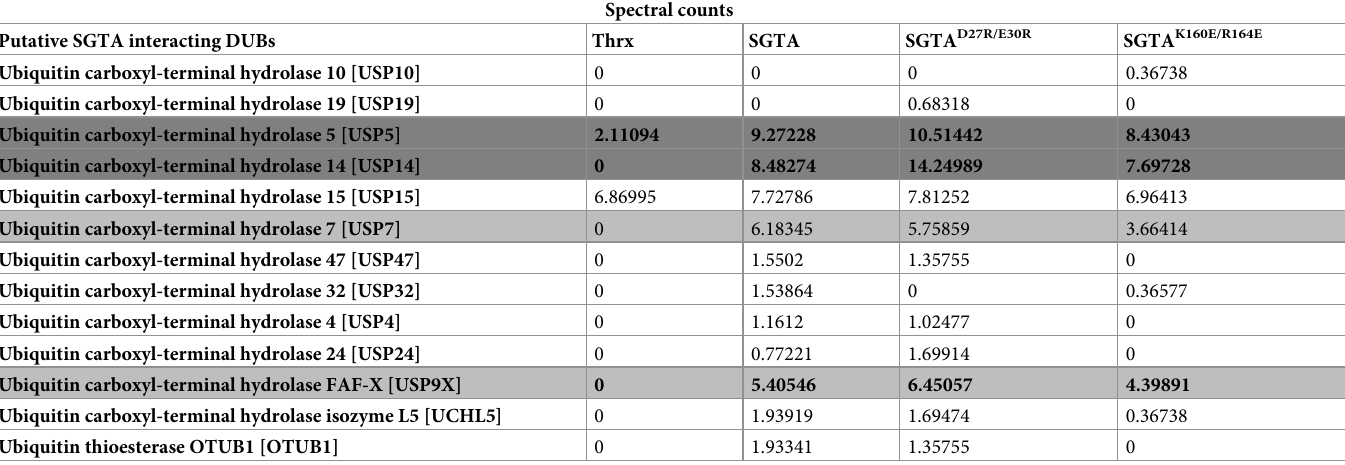
Table 2. Putative SGTA interacting DUBs identified by mass spectrometry. Pull-down experiments were performed as described in Materials and Methods. The beads were then analysed for bound proteins by mass spectrometry as detailed in the materials and methods. All DUBs identified from the mass spectrometry are shown together with the spectral counts. The DUBs highlighted were prioritised for further studies based on high spectral counts and low background in the negative